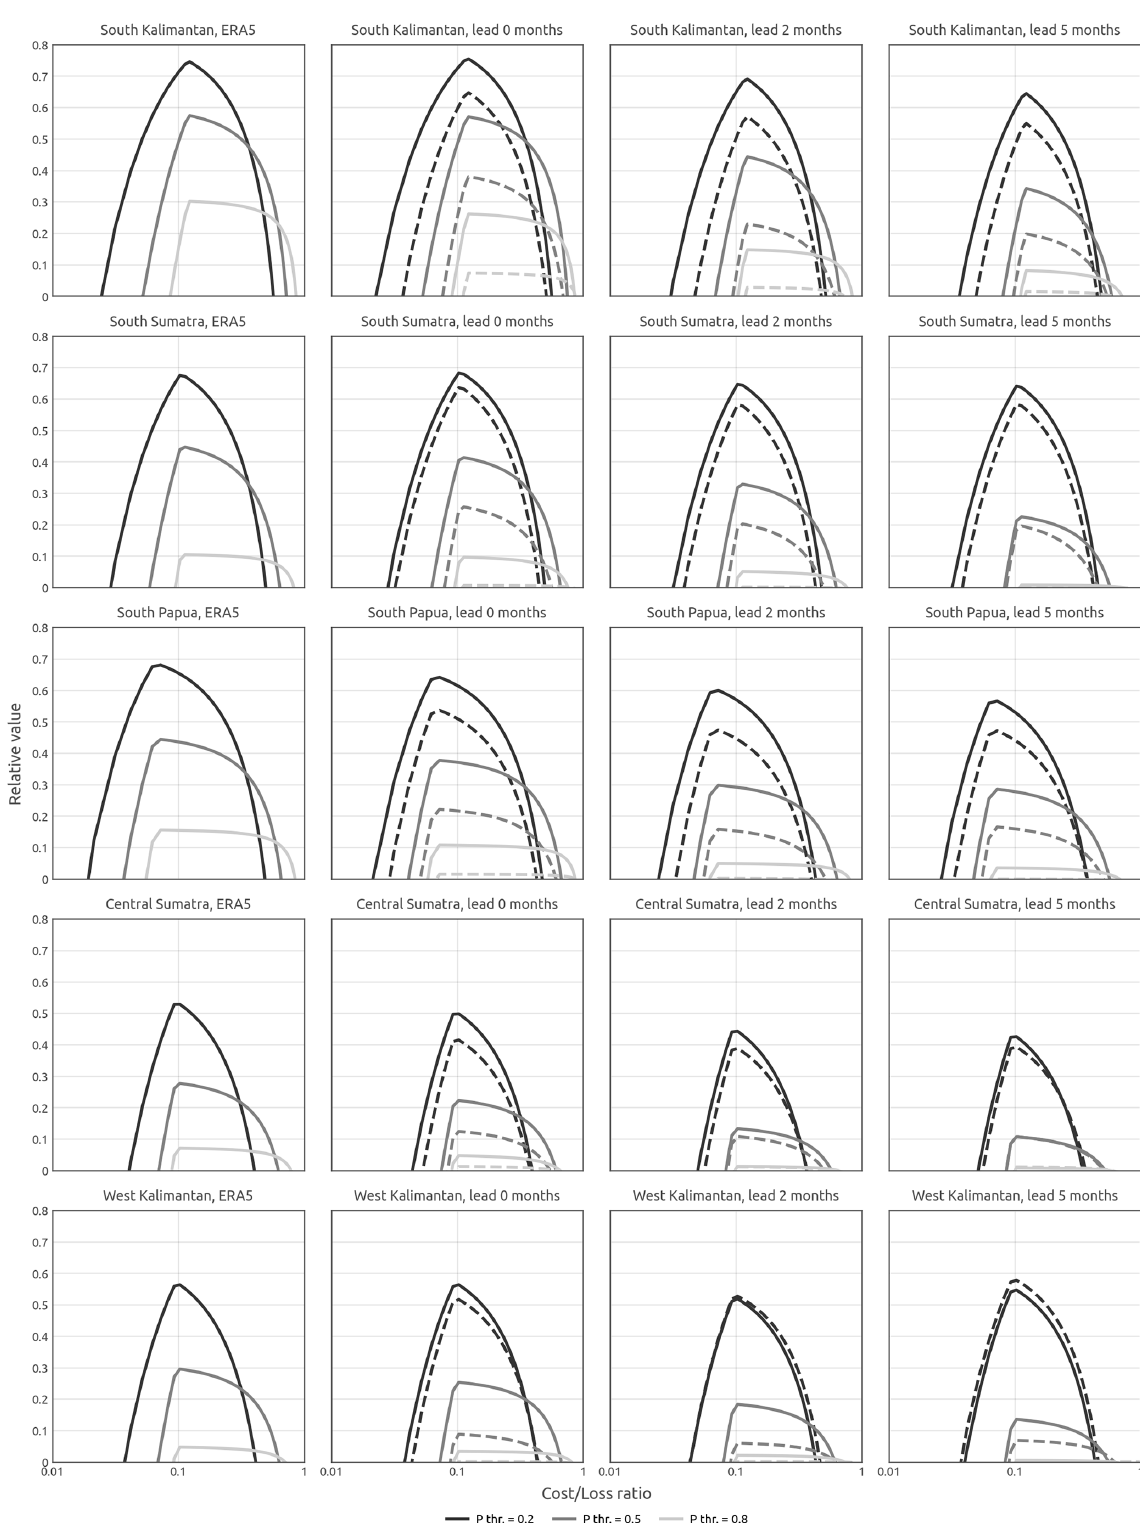
Figure 9. Relative value of prediction of an active-fire count of > 10 cases for users with different cost–loss ratios. Shown are relative values of ERA5-based predictions and SEAS5-based (solid lines) and climatology-based (dashed lines) predictions at different lead times (columns) for different sub-regions (rows). Line shading (legend) indicates different fire prediction probability thresholds (P thr.) at which the relative value curves are